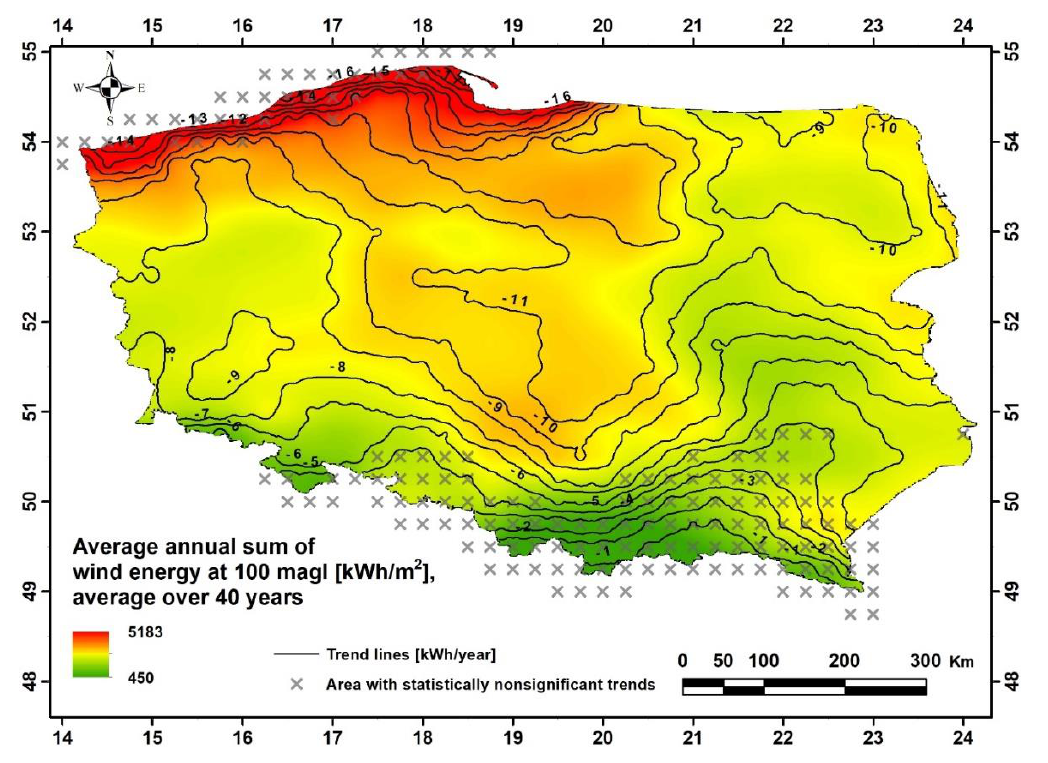
Figure 2. Spatial distribution of wind resources in Poland. Data represents mean resource availability at 100 m a.g.l. calculated from hourly time series for 1980 – 2019. Contour lines represent linear trends.